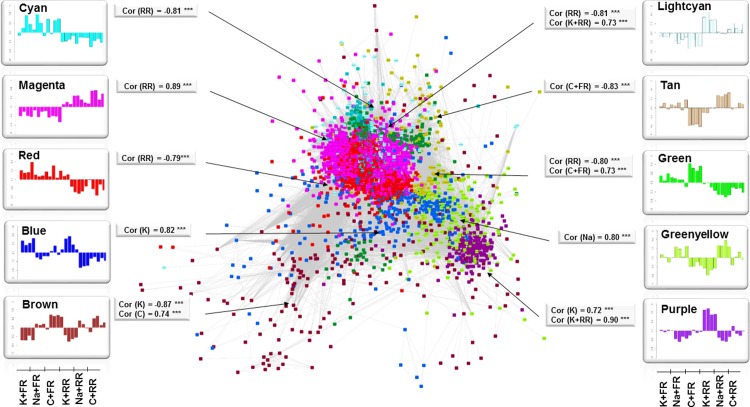
Representation of the 10 network modules and corresponding bar plots representing the gene expression level for each treatment, with four replicates per treatment.The number of genes (n), the most significant R correlation values (Cor > 0.70 and pval > 0.05) and the corresponding level of significance (ns > 0.05; *< 0.01; **< 0.001; ***< 0.0001) per treatment are given for each module. Gene expression was significantly affected by reduced rainfall (RR = Cyan, Magenta, Red, Lightcyan, Green), potassium and reduced rainfall (K and RR = Lightcyan, Purple), control and full rainfall (C and FR = Tan, Green), potassium (K = Blue, Brown, Purple), sodium (Na = GreenYellow), control (C = Brown).